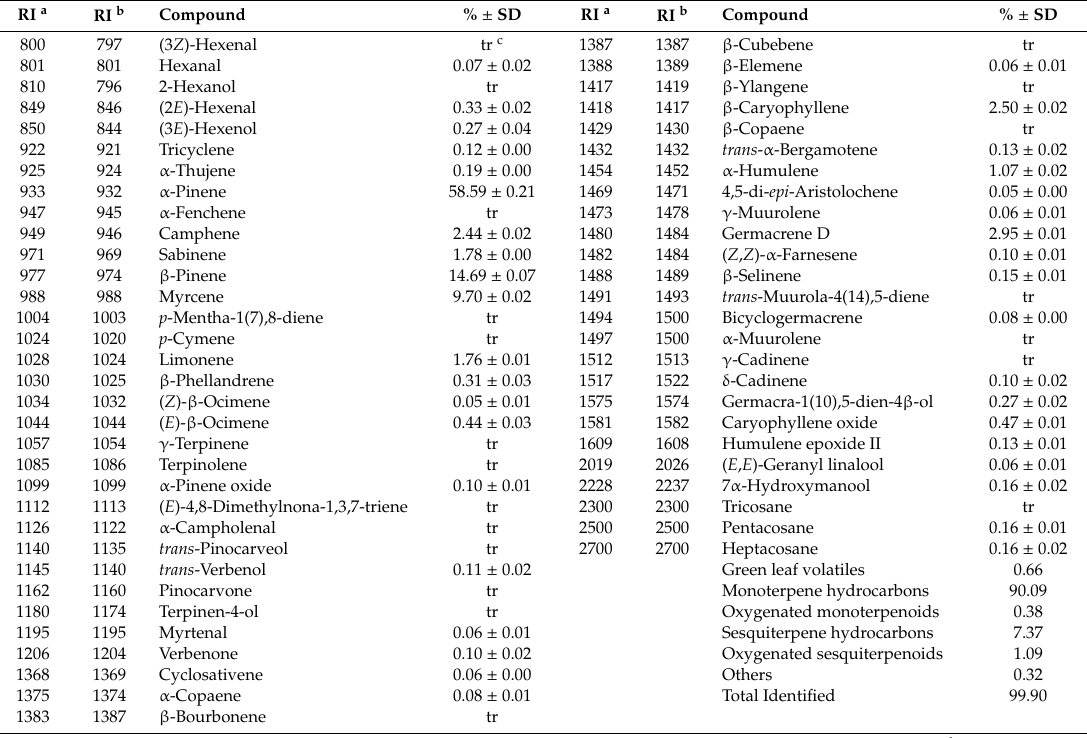
Table 7. Chemical composition of the essential oil of Silphium integrifolium Michx.